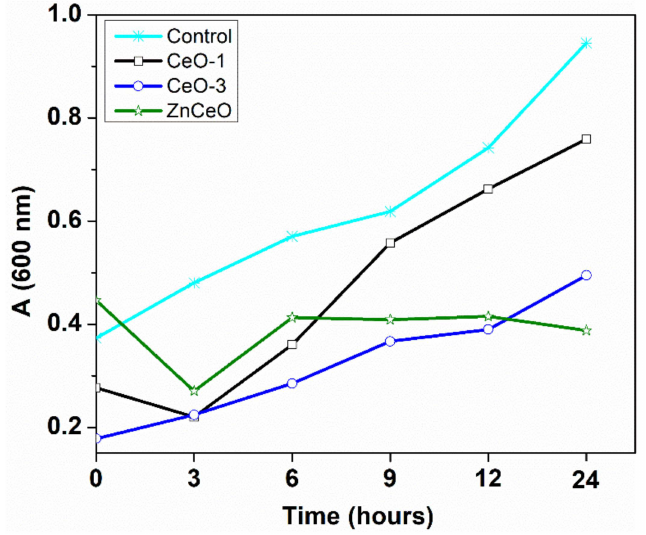
Figure 11. Growth curves of Escherichia coli treated with cerium oxide